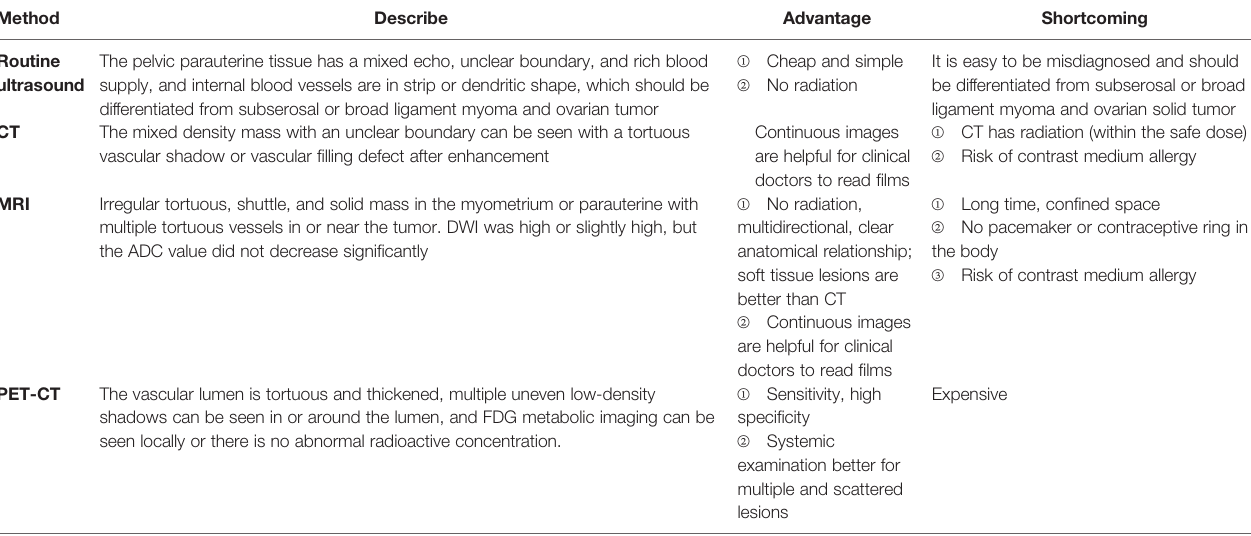
TABLE 2 | The traditional imaging detection of IVL.